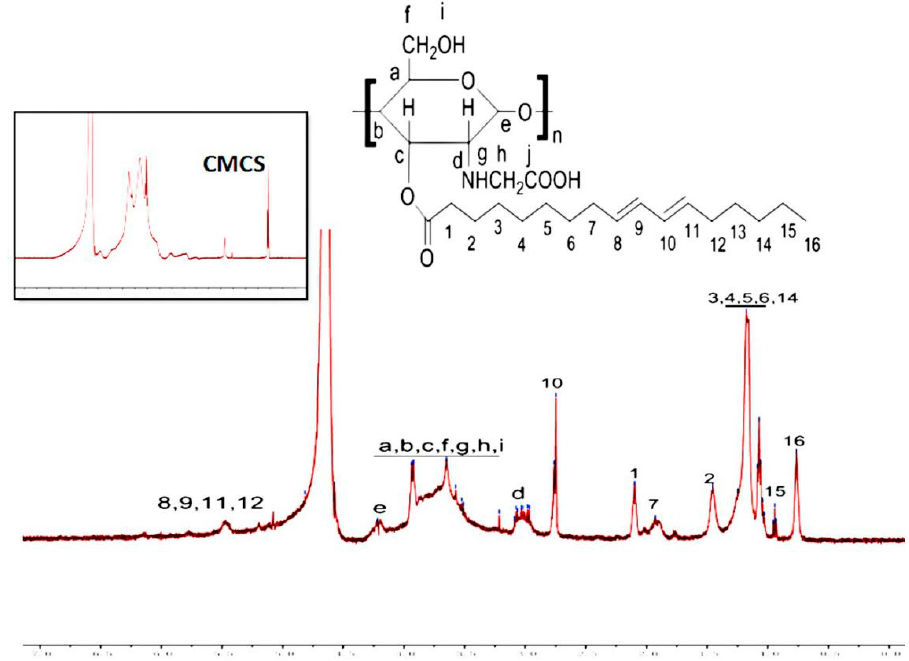
Figure 2. 1 H NMR spectra of CMCS and CC3.